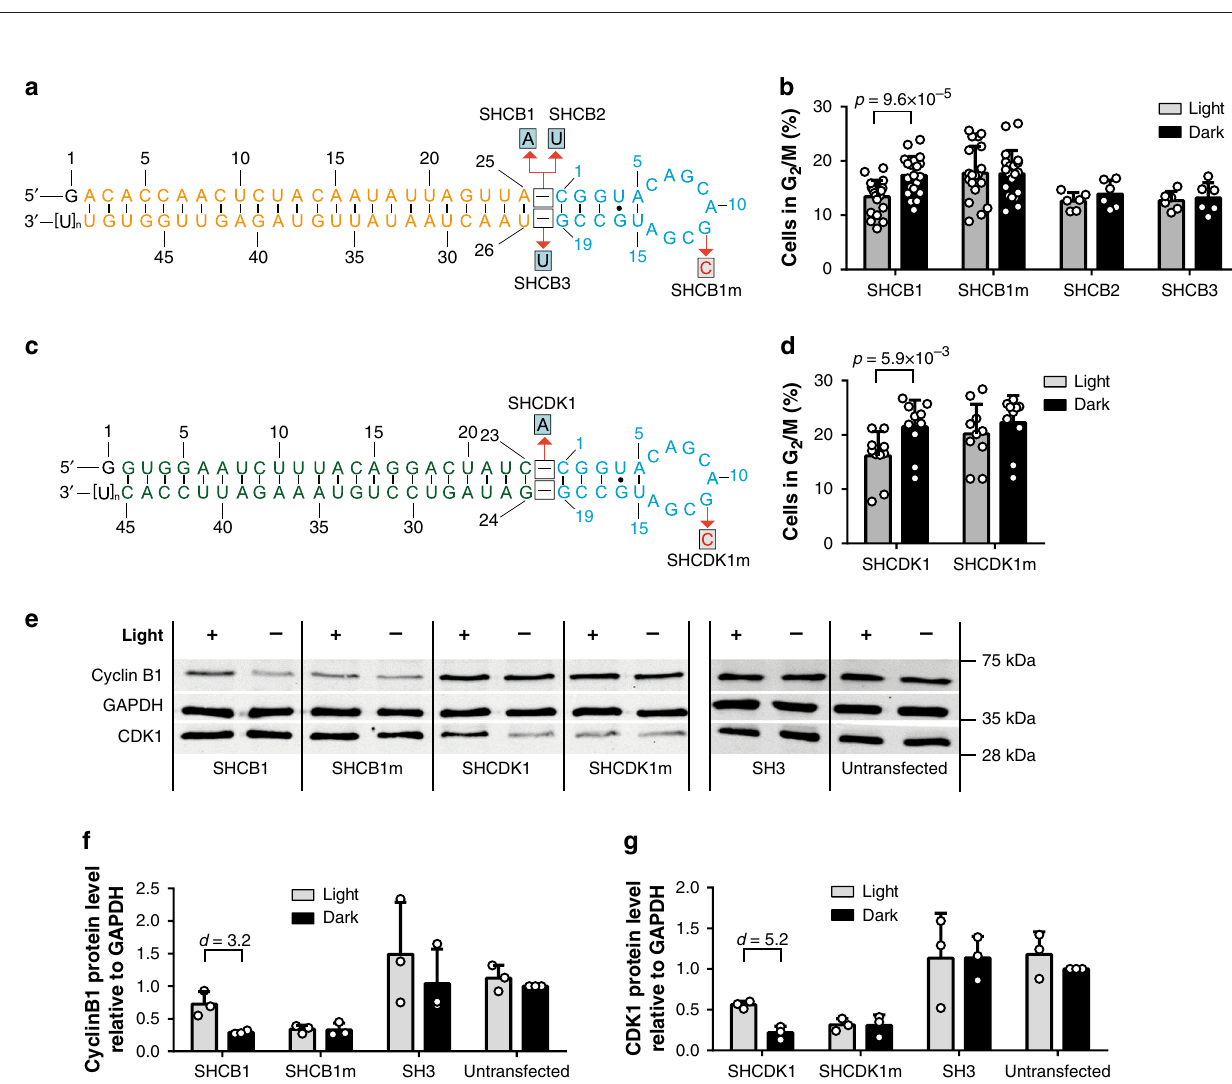
Fig. 3 Design of shRNAs for the light-dependent expression of eGFP. Two different siRNA sequences SH1 (orange box, a ) and SH2 (green box, b ) targeting eGFP mRNA were conjoined with the PAL aptamer (blue boxes) as apical loop domains. Black arrows indicate a putative preferential dicer cleavage site 44 . c Number of cells expressing eGFP after transfection of SH1 or SH2. Values are normalized to SHA (Fig. 2a) in darkness. d Fold changes calculated from light vs. dark conditions from ( c ). e Single nucleotide permutations of the hinge region in SH1 and their impact on eGFP expression and light dependency ( f ). Values are normalized to SHA in darkness. g Fold changes calculated from light vs . dark conditions from ( f ). h Single nucleotide permutations of the hinge region in SH2 and their impact on eGFP expression and light dependency ( i ). Values are normalized to SHA in darkness. j Fold changes calculated from light vs . dark conditions from ( i ). k Fluorescence microscopy images of cells transfected with the indicated shRNA variants. Cells were incubated under either light or dark conditions. Scale bar: 40 μ m. c , f , i N = 12 (SHA, SH1, SH3) or 6 (all others). d , g , j N = 24 (SHA, SH1, SH3) or 12 (all others). c – k Each biologically independent experiment was performed in duplicates. Gray bars: light conditions, black bars: dark conditions. Dark gray bars: fold changes. Values are means ± s.d. Source data for ( c , d , f , g , i , j ) are provided as a source data fi le.